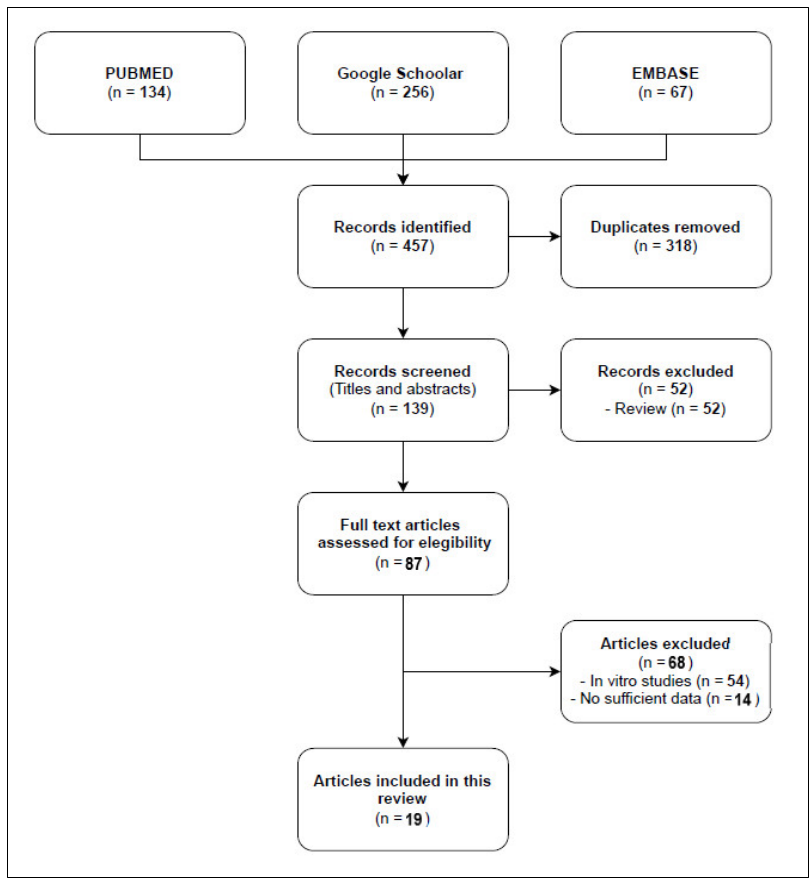
Figure 1. Flow diagram study selection process.